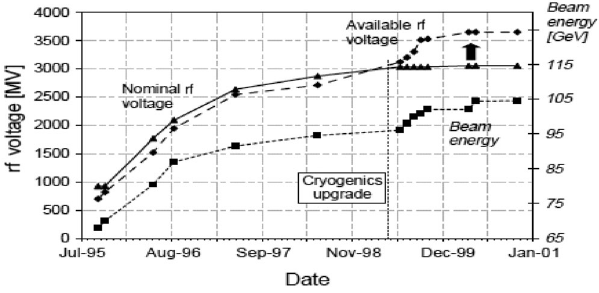
FIG. 25. Radio frequency voltage per turn over the